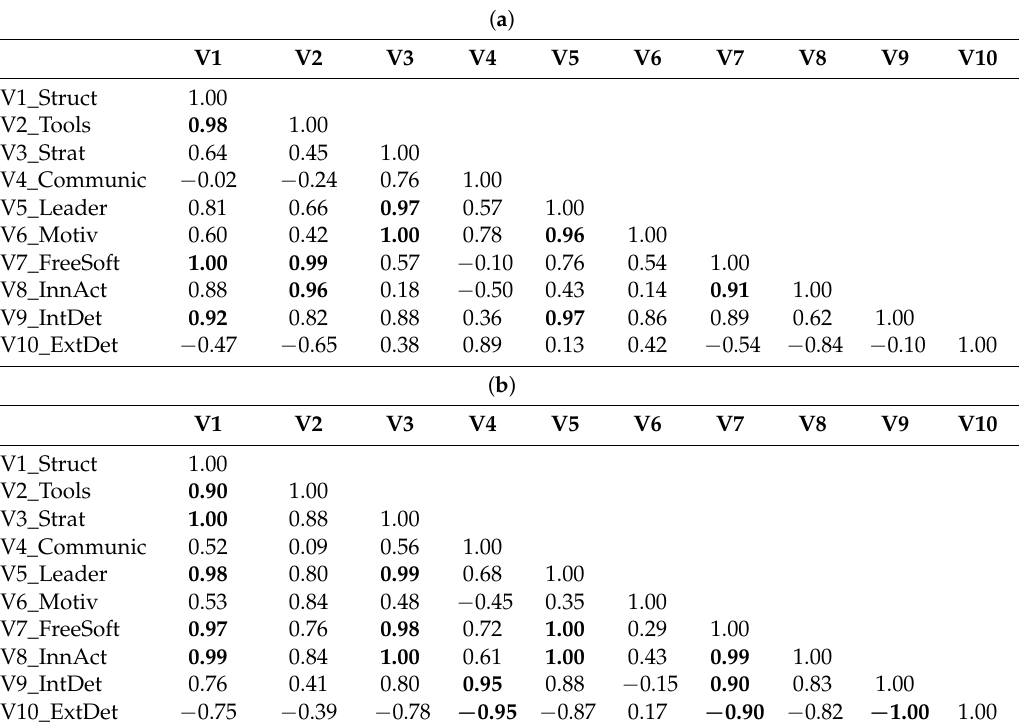
Table 3. ( a ) Correlation Matrix/Analysis of Results. ( b ) Correlation Matrix/Analysis of Impacts. ( a